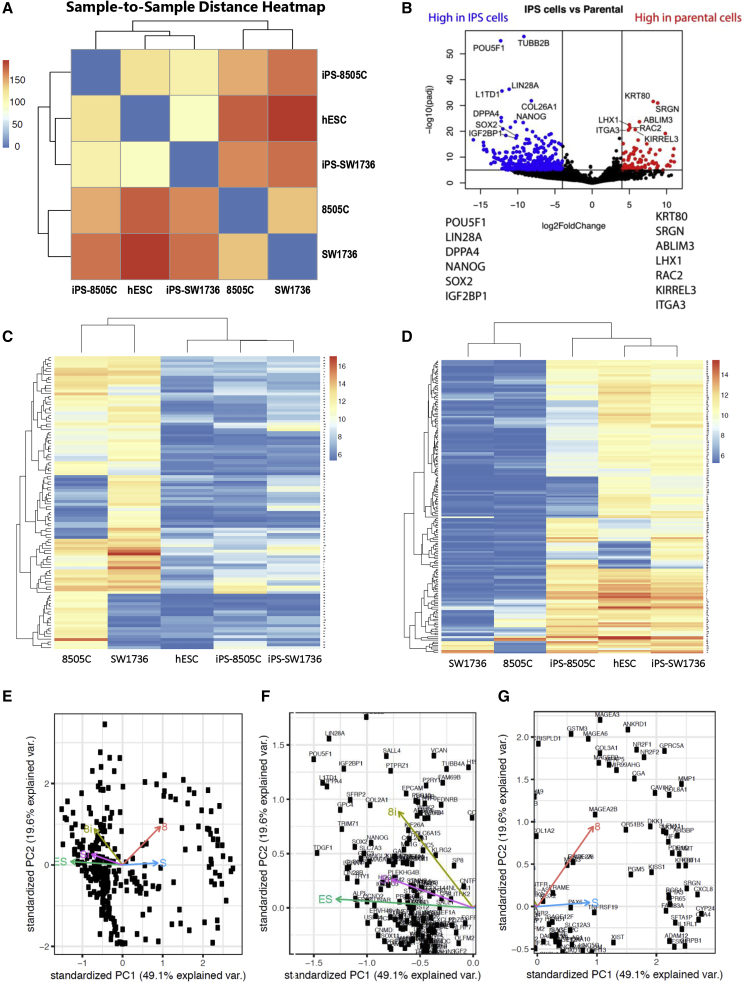
Cancer Cell-Derived hiPSCs and hESCs Have Similar Gene Expression Patterns(A) Sample-to-sample distance heatmap between samples based on global transcriptional profiling by RNA-seq showed that the gene expression of the hiPSCs derived from each cancer cell line (iPS-8505C and iPS-SW1736) was very similar to that of hESCs, but very different from that of the cancer starting cells (8505C and SW1736, respectively).(B) Volcano plot showing differentially expressed genes between hiPSCs and their respective parental cancer cells. Blue dots indicate genes upregulated in hiPSCs, while red dots indicate genes upregulated in parental cancer cells by RNA-seq analysis. The dots for some representative key genes, for example, those listed at bottom left and bottom right, are labeled.(C and D) Heatmaps showing genes downregulated (C) and upregulated (D) after hiPSC induction as measured by RNA-seq analysis showing that the hiPSC groups (iPS-8505C and iPS-SW1736) together with hESCs in both categories, and not with the parental cancer lines (8505C and SW1736, respectively). (Biocarta analysis of the RAS pathway alone in hESCs is provided in Figure 6A.)(E–G) Principal component analysis of the five cell lines from this study (parent ATC line 8595C and its reprogrammed hiPSC line iPS-8505C, ATC line SW1736 and its reprogrammed hiPSC line iPS-SW1736, and hESCs) from RNA-seq data overlaid upon each other (E). In (F) and (G), the information is segregated to allow better visualization. hiPSCs showed a similar gene expression pattern to hESCs (F) while the parental cancer cells showed similar gene expression patterns to each other but distinct from the hiPSCs and hESCs (G).